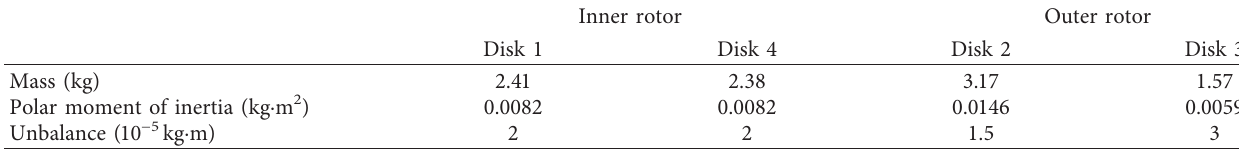
Table 2: Inertial attributes and unbalanced configuration of the disks.